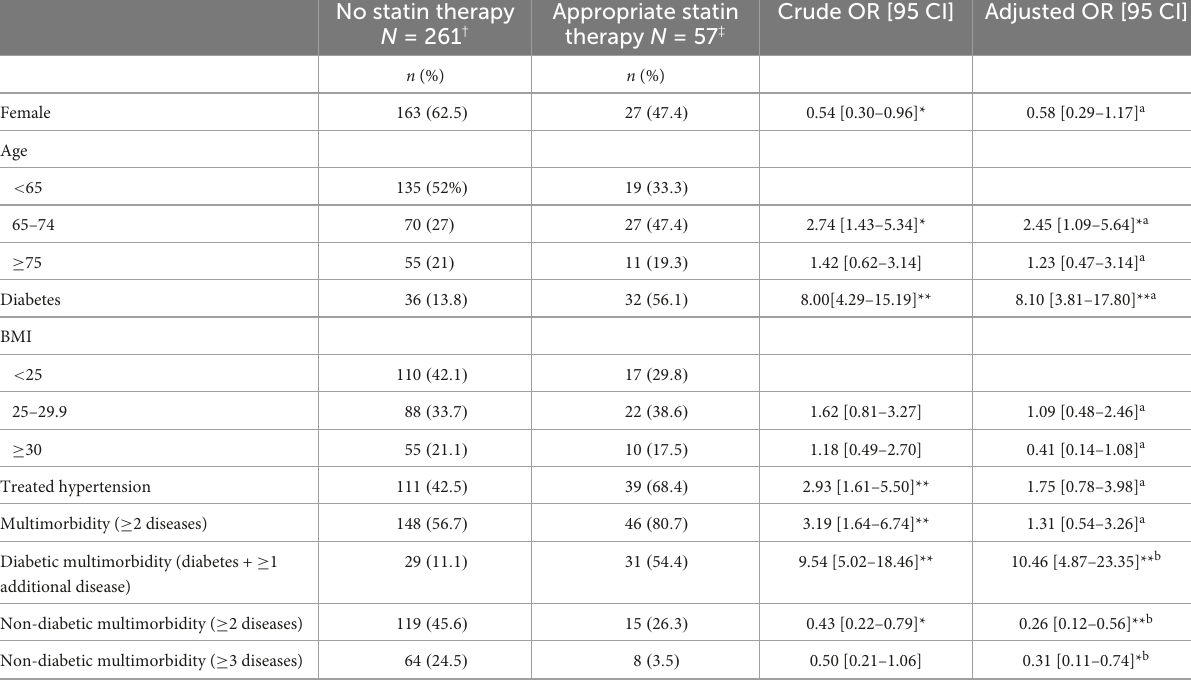
TABLE 3 Univariate and multivariate analysis of factors associated with appropriate statin prescription according to the 2016 European Society of Cardiology (ESC)